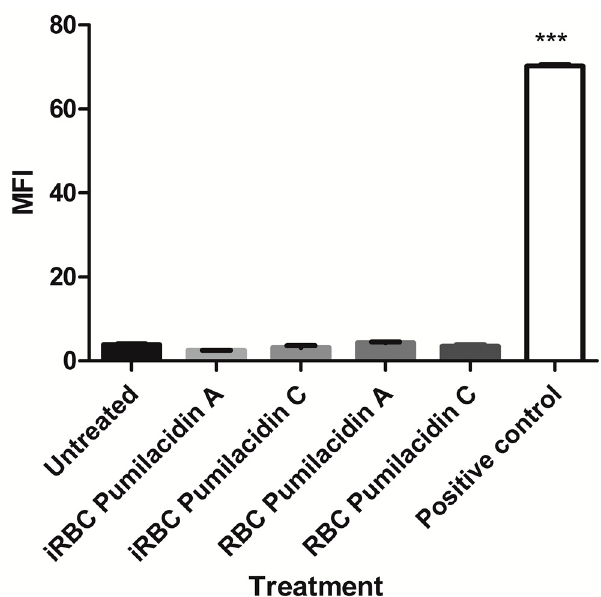
Figure 5. Effect of pumilacidins on cell-membrane integrity. Infected and uninfected red blood cells were cultured with pumilacidins A and C at 10 µ M for 3 h. As a positive control, heating at 80 ◦ C was used. Integrity of the membranes was determined by the incorporation of propidium iodide (PI) measured by flow cytometry and plotted as mean fluorescence intensity (MFI). Data represent the means ± SEM of one representative experiment performed in triplicate. *** p < 0.001.